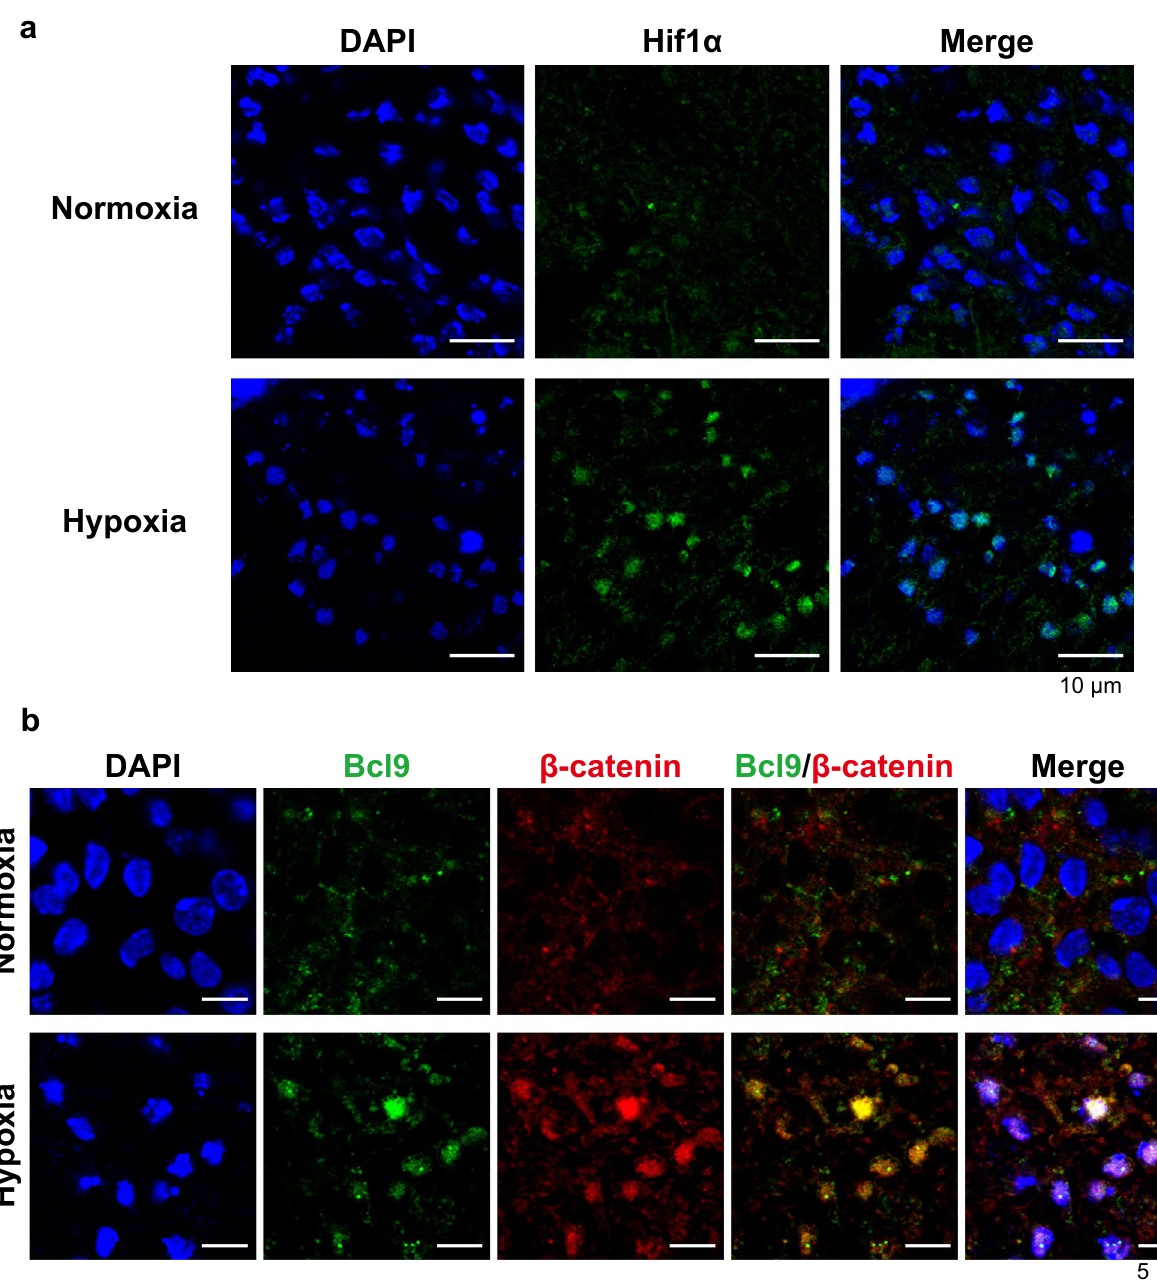
Figure 6. Mouse dental pulp tissues cultured under hypoxic culture show increased expression of Hif1α and Bcl9, and nuclear co-localization of Bcl9 and β-catenin. ( a ) Immunofluorescence detection of Hif1α in mouse dental pulp tissue in hypoxic culture (1% O 2 ) for 48 h. Hif1α expression is increased and detected in the nucleus. ( b ) Immunofluorescence detection of Bcl9 and β-catenin in mouse dental pulp tissue in hypoxic culture (1% O 2